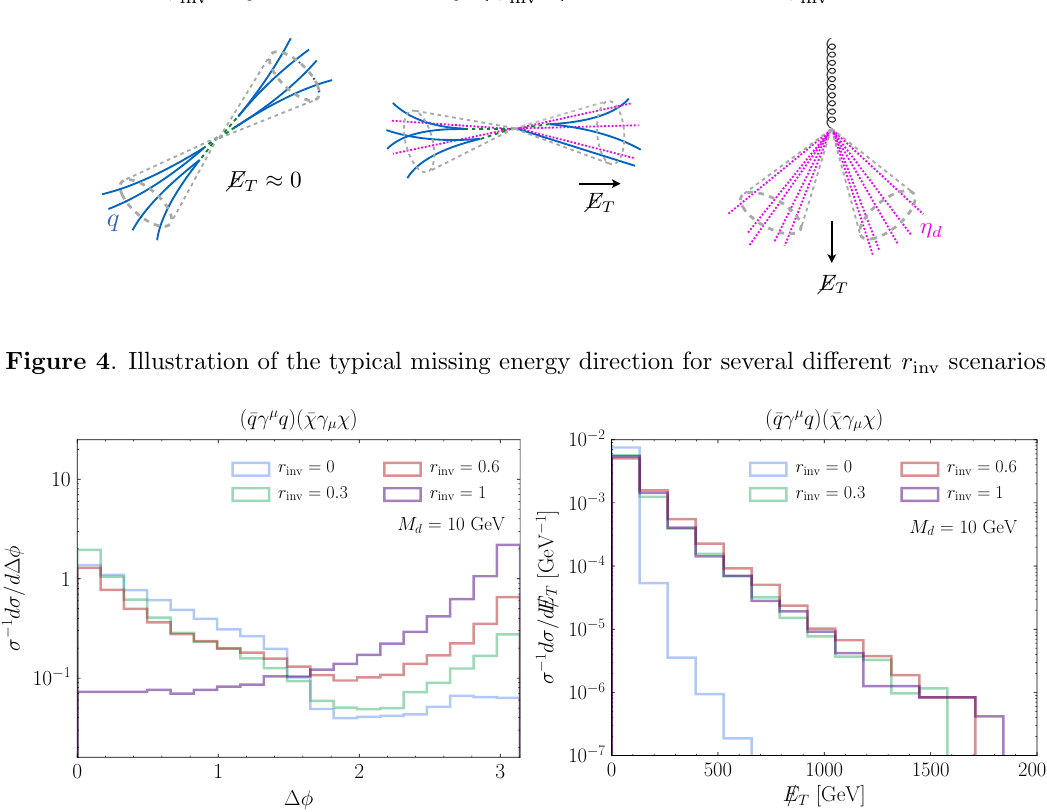
Figure 5 . Kinematic distributions for (cid:1) (cid:30) (left) and missing energy (right) before trigger and preselection cuts are applied. The distributions correspond to the vector contact operator, with M d = 10 GeV and r inv = 0 ; 0 : 3 ; 0 : 6 ; 1 : 0 (blue, green, red and purple,